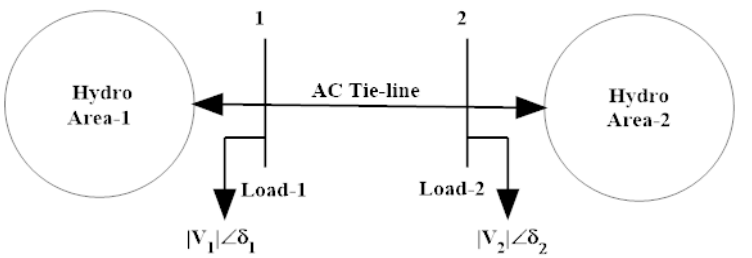
Figure 1. An AC tie-line connects area-1 with area-2 with each area generated power via a hydropower plant.